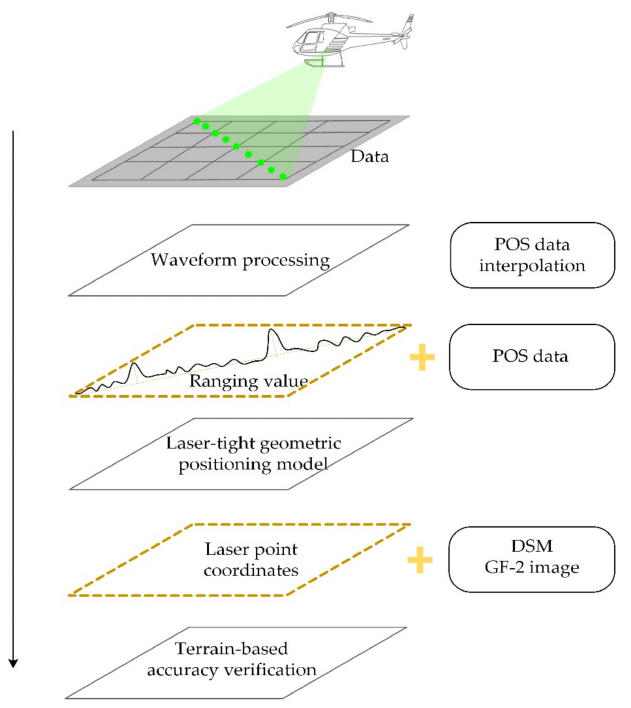
Figure 2. Flow chart of the proposed lidar data processing